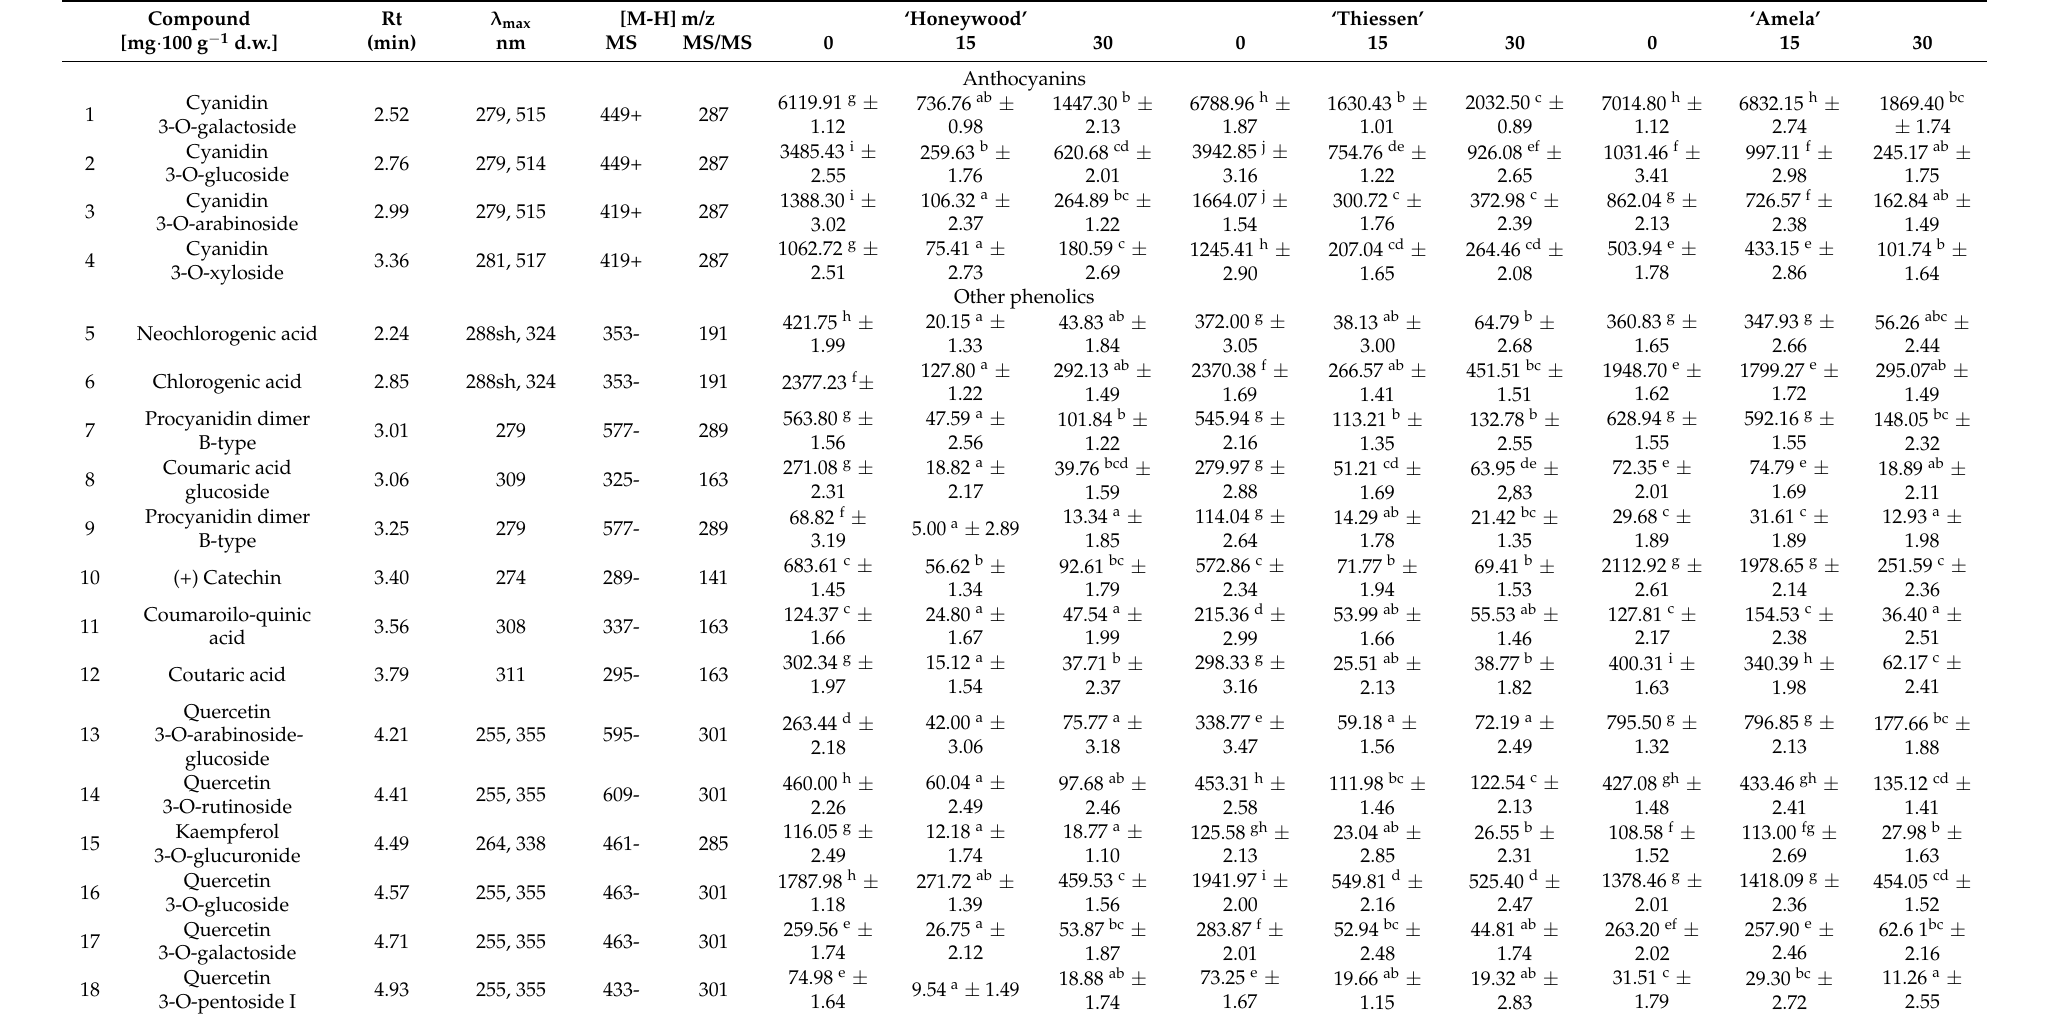
Table 5. Individual phenolic compounds identified by UPLC-PDA-MS/MS in Saskatoon